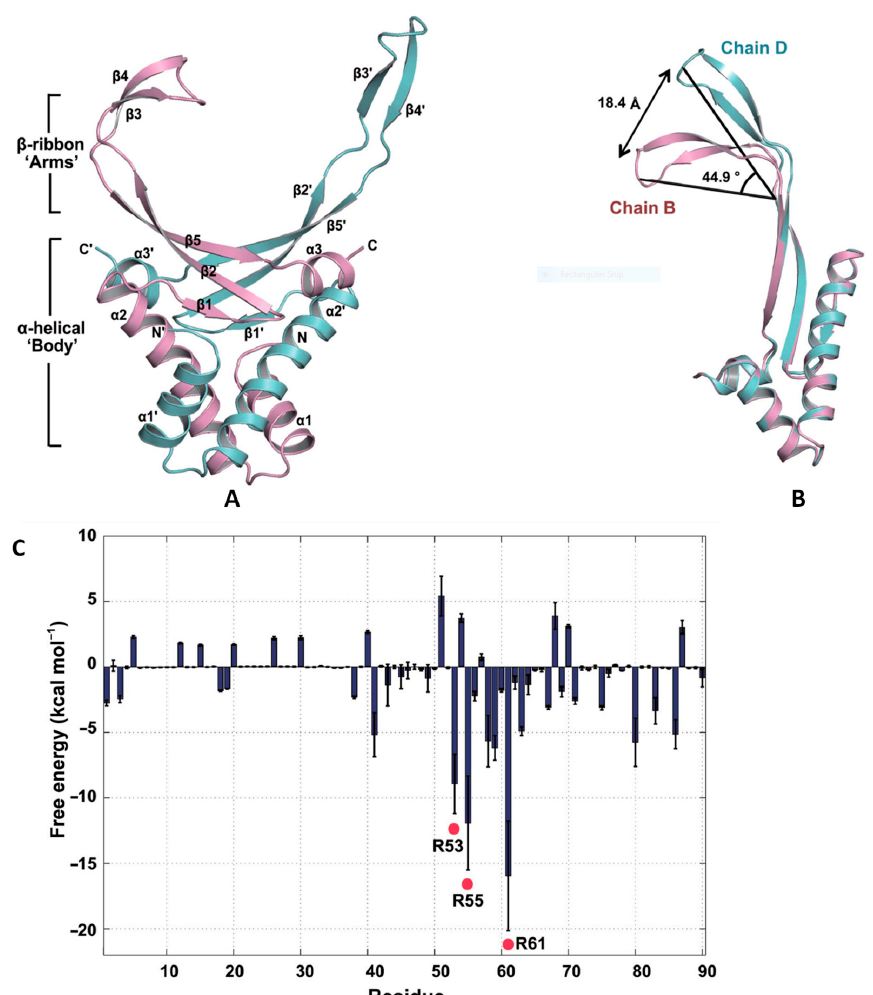
Figure 9. HU structure and the arginine residues involved in its DNA-binding site. ( A ) Ribbon diagram of the SHU homodimer. The α –helices, β –sheets and the N– and C–termini are labelled. The residue Arg55 is labelled in a circle. ( B ) The flexible β –ribbon arms deviate with a distance of 18.4 Å and with a bending angle of approximately 44.9°. ( C ) The binding free energies in the SHU–DNA complex, as determined by MD simulation. The three Arg residues (Arg53, Arg55 and Arg61) that show low free energies are marked with red points. Adapted from Kim et al. [139].